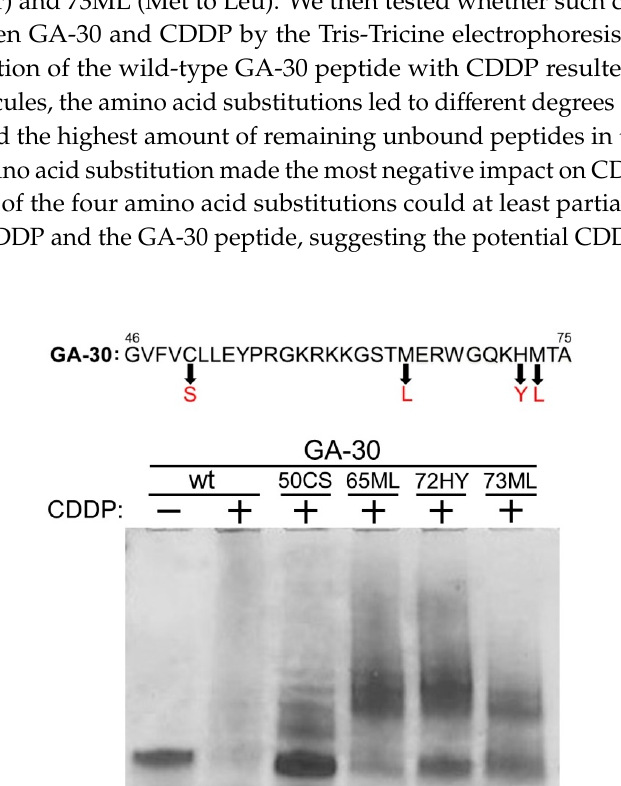
( C ) The p22phox peptides, MN-11 (1.3 kDa), GA-30 (3.5 kDa), VL-21 (2.5 kDa) and VI-29 (2.85 kDa), were incubated in PBS bu ff er with or without CDDP (1 mM) at room temperature overnight. The reactions were analyzed by Tris-Tricine SDS-PAGE and silver staining. ( D ) The GA-30 peptide (100 µ M) was incubated with the indicated doses of CDDP at room temperature overnight and then analyzed by Tris-Tricine SDS-PAGE and Coomassie blue staining. The star and arrowhead denote the putative peptide dimer and unbound peptides, respectively. ( E ) The GA-30 peptide (10 µ g) was incubated with 1 mM CDDP for the indicated time periods and then analyzed as in (D). ( F ) The LC–MS extracted spectrum of CDDP-modified peptides shown in di ff erent charge statuses. The unmodified peptides: m / z = 1374.64 with 1 charge, m / z = 687.83 with 2 charges and m / z = 458.89 with 3 charges. The Pt-modified peptides: m / z = 784.30 with 2 charges, m / z = 522.87 with 3 charges and m / z = 390.42 with 4 charges. The PtNH 3 -modified peptides: m / z = 793.31 with 2 charges, m / z = 529.21 with 3 charges and m / z = 397.16 with 4 charges.